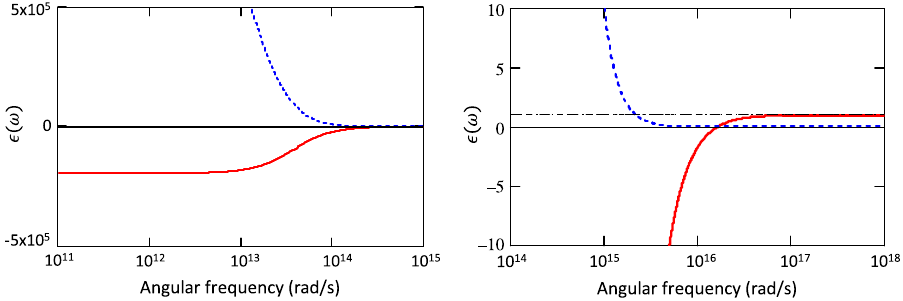
FIG. 1. The complex dielectric function for copper at room temperature with different vertical and horizontal scales. The real part is plotted with the solid red curves, and the imaginary part is plotted using dashed blue curves. The plasma frequency is 1 . 64 × 10 16 rad = s and is the frequency where the real part is zero.